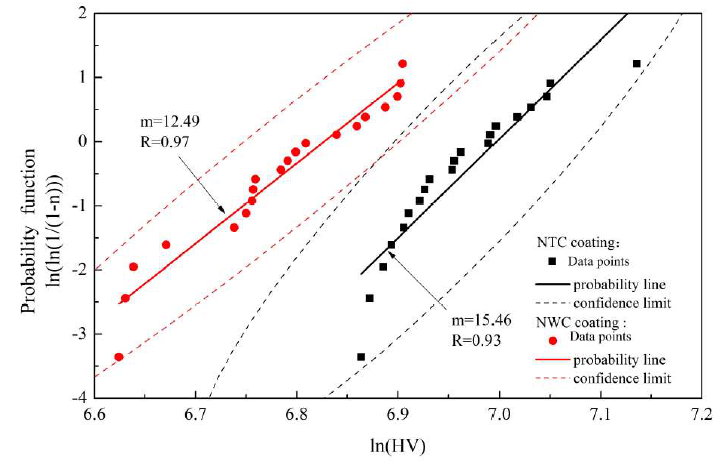
Figure 8. Weibull distribution plot of the microhardness of NTC and NWC coatings.